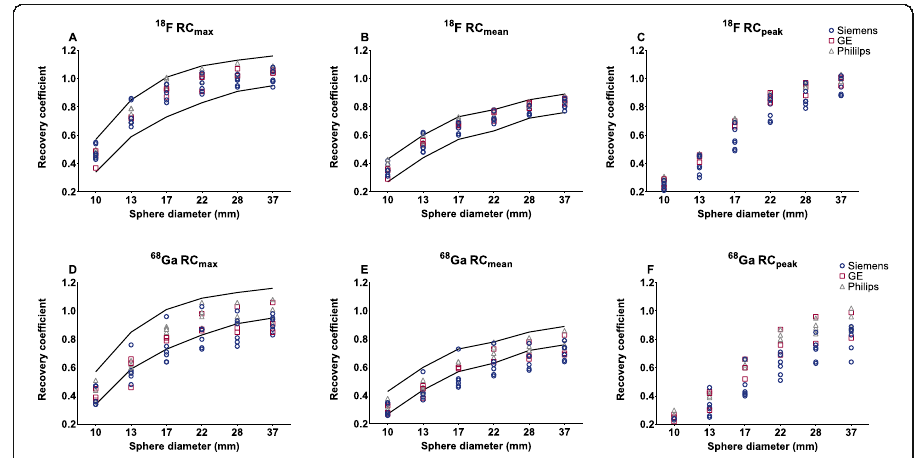
Fig. 3 RC for 18 F with the current EARL standards and RC of 68 Ga. Solid lines: maximum and minimum values according to EARL limits as applicable before 2019